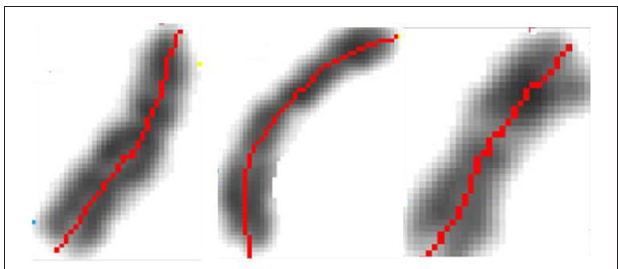
FIGURE 17 | Identification of the central meridian-line of a chromosome before normalization-“rectification,” the feature preparation for the metric-comparison (Jovanovi´c, 2001; Jovanovi´c et al., 2014).